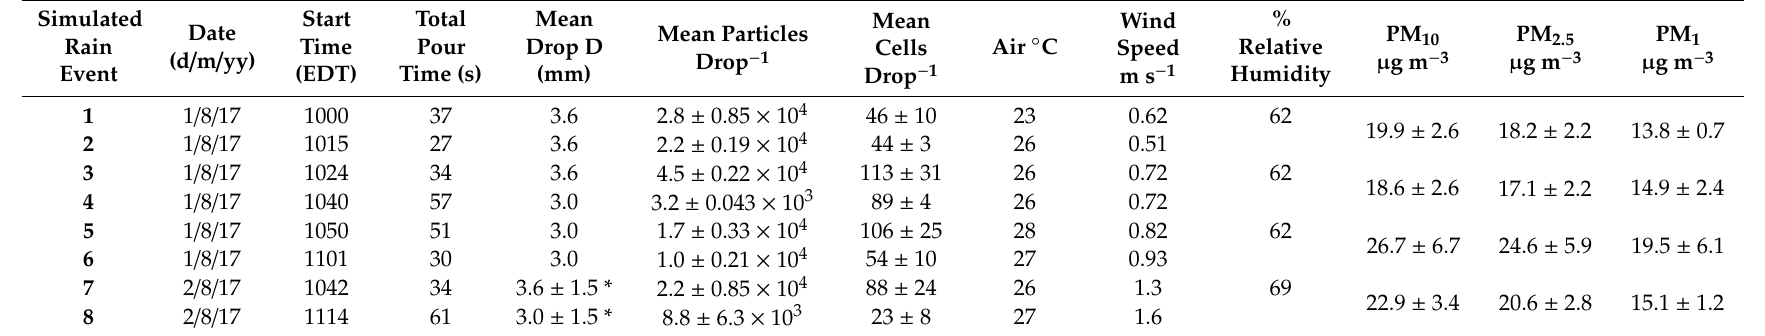
Table 1. Total particle, cell, and environmental data from simulated rain events. The total particles and cells scavenged (0.2 to 2 µ m in diameter) are average concentrations ± standard error of the mean, n = 3. (EDT: Eastern Daylight Time).